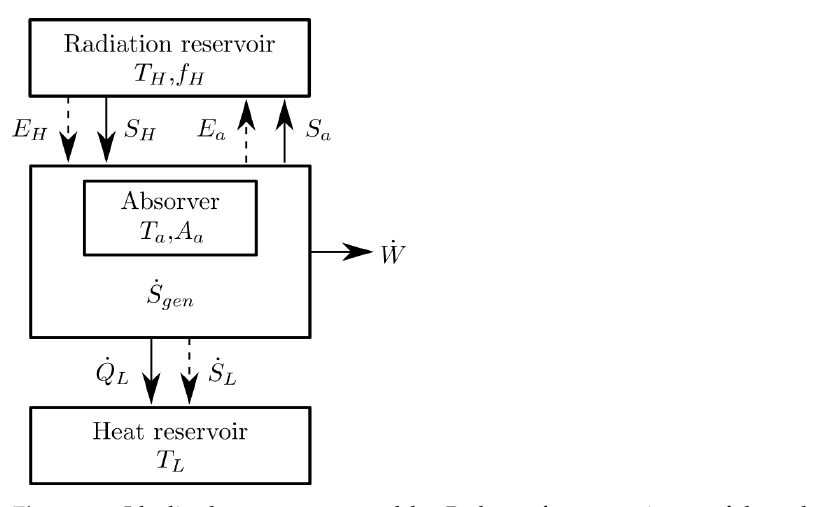
Figure 3. Idealised system proposed by Badescu for extracting useful work from a radiation reservoir